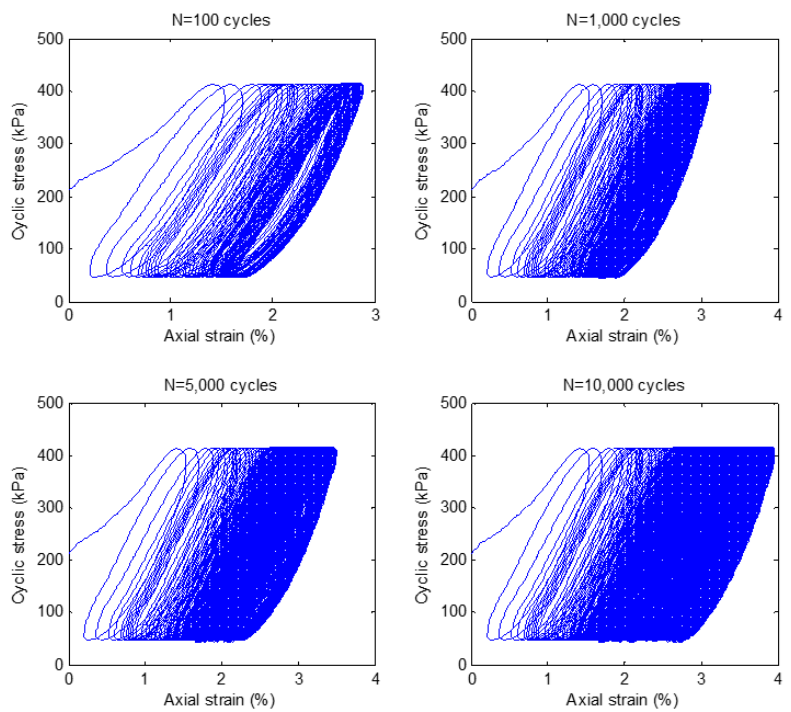
Figure 17. Predicted cyclic stress versus axial strain at varying number of load cycles (Ngo et al. [60]—with permission from ASCE).